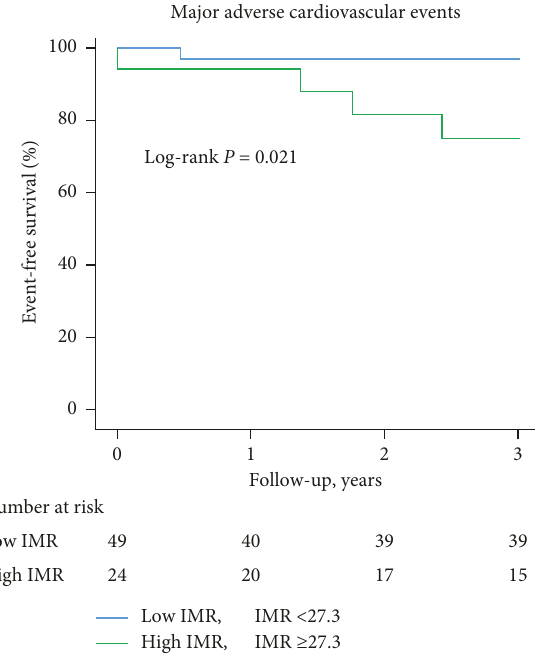
Figure 3: Kaplan–Meier curve between the high and low IMR group. IMR: index of microvascular